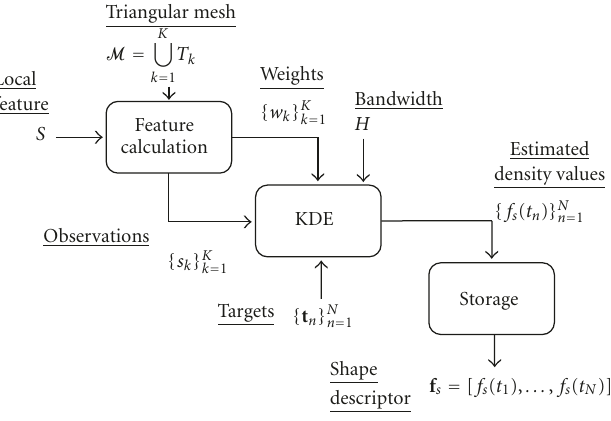
Figure 4: Flow diagram to compute a density-based 3D shape descriptor when the bandwidth is set at database